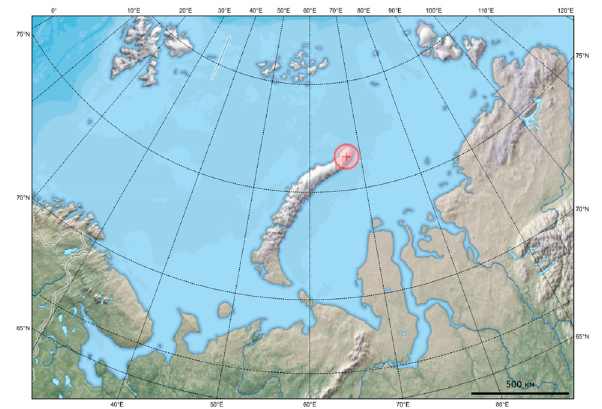
Figure 1. Sampling region map. Red circle indicates sampling site location. The map in more detailed scale is presented on Figure A1.